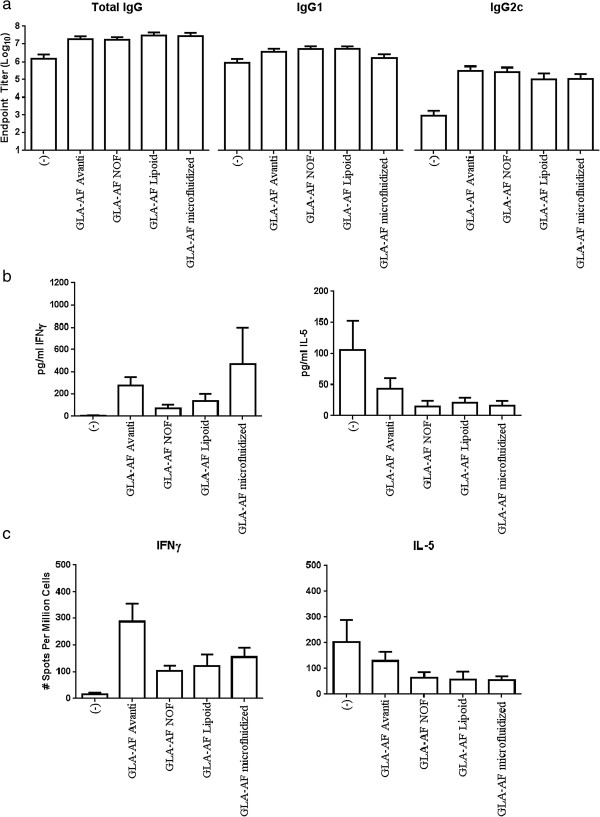
In vivo adjuvant activity elicited by PbCSP antigen with GLA-AF. (a) Antibody endpoint titers measured two weeks after the second immunization. Each group consisted of 4–5 mice immunized with 1 μg GLA-AF and 2 μg PbCSP. Each of the adjuvanted groups achieved statistical significance in IgG2c titers compared to PbCSP alone (p < 0.05). No other statistical differences between groups were apparent. (b) Cytokine ELISAs of splenocytes collected six weeks after the third immunization and stimulated with antigen. Each group consisted of 5 mice immunized with 1 μg GLA-AF and 2 μg PbCSP, with each value consisting of an average of two duplicates. No statistical differences between groups were present. (c) Splenocytes producing cytokines six weeks after the third immunization, detected by ELISPOT assay. Each group consisted of 5 mice immunized with 1 μg GLA-AF and 2 μg PbCSP, with each value consisting of an average of two duplicates. The number of IFNγ-producing cells from the PbCSP + GLA-AF Avanti group acheived statistical significance (p < 0.05) compared to PbCSP alone, PbCSP + GLA-AF NOF, and PbCSP + GLA-AF Lipoid. No other statistical differences between groups were apparent.